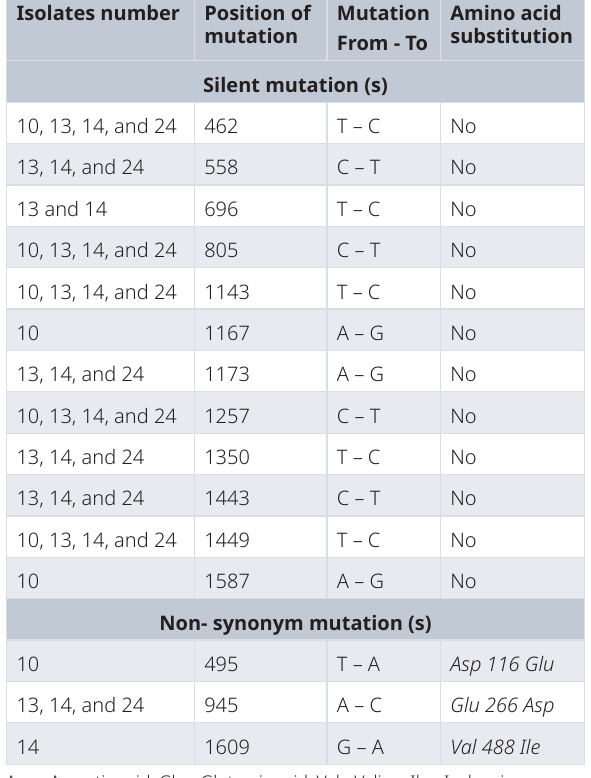
Table 3. Different mutations of ERG11 gene and amino acid substitutions. Isolates number Position of Mutation Amino acid mutation From - To